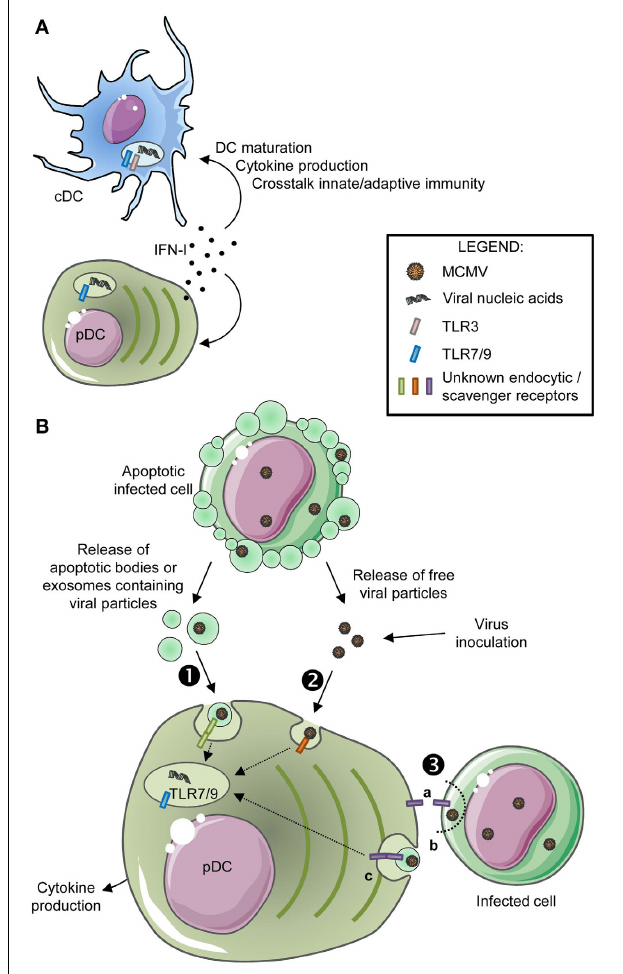
FIGURE 2 | Molecular mechanisms regulating DC subset activation during MCMV infection. (A) Mechanism promoting DC subset maturation in vivo during MCMV infection. High amount of IFN-I are produced in vivo by pDC early after MCMV infection, which drives broad cell-intrinsic responses in all DC, including canonical DC maturation, promoting protective crosstalk with innate and adaptive immune cells. (B) Mechanisms promoting pDC sensing of MCMV infection. Early after completion of the first cycle of virus replication in vivo , pDC sense MCMV nucleotide sequences via endosomal TLRs, which leads to innate cytokine production, in particular IFN-I. How MCMV material ends up in the endosomes of pDC is still not understood. pDC might specifically recognize and engulf materials derived from infected cells and containing viral nucleic acids, either apoptotic bodies or exosomes ( ➊ ). pDC may also be able to detect and engulf MCMV particles released by infected cells or even from the viral inoculum ( ➋ ). Finally, pDC may directly sense and nibble infected cells ( ➌